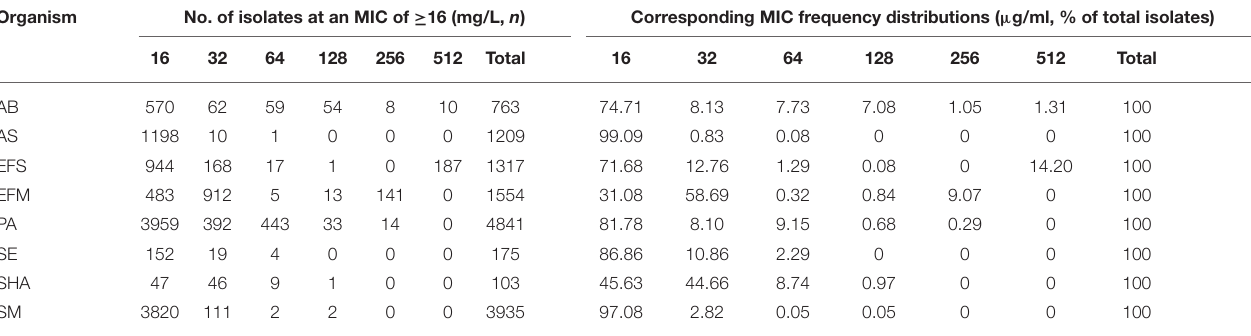
TABLE 2 | No. of targeted bacterial isolates and corresponding MIC frequency distributions at MICs ≥ 16 mg/L collected from the EUCAST database. Organism No. of isolates at an MIC of ≥ 16 (mg/L, n ) Corresponding MIC frequency distributions ( µ g/ml, % of total